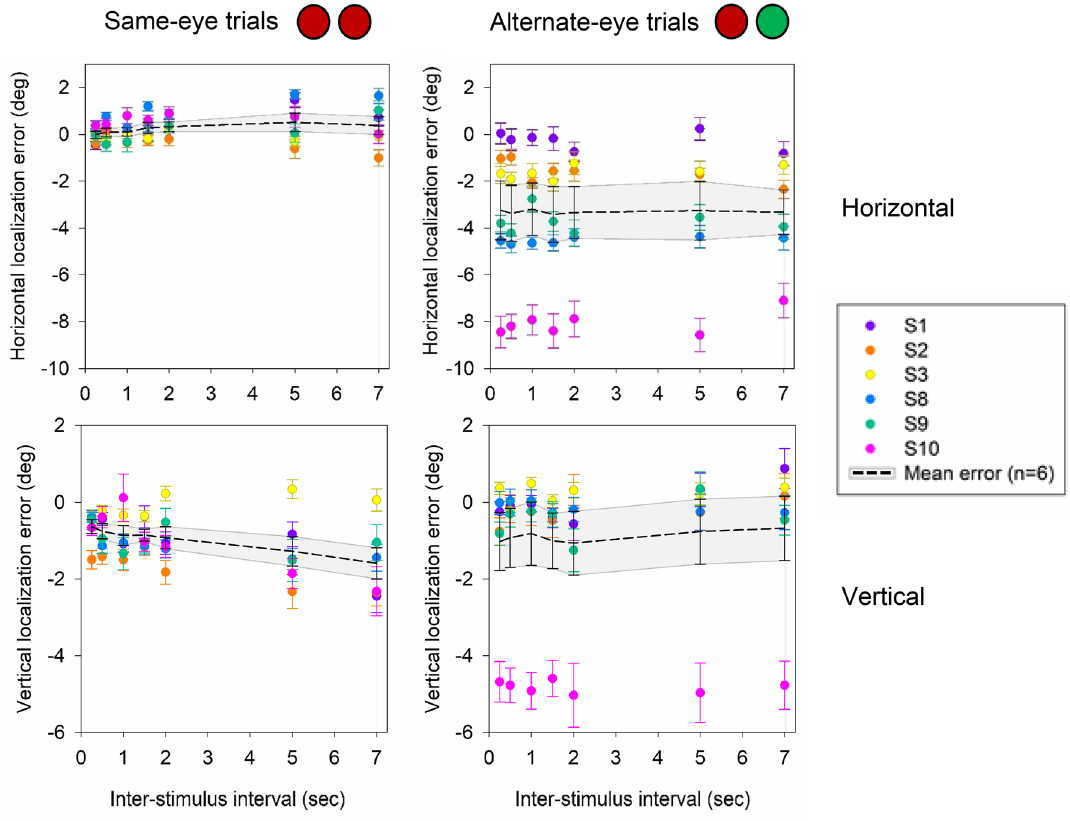
Figure 6. Scatter plot displaying the mean horizontal and vertical localization error across inter-stimulus interval for same eye (LL and RR) and alternate eye (LR and RL) conditions. Black dashed line represents the mean localization error and grey shading represents the standard error of localization for all subjects (n = 6). Each color represents the mean and standard error of horizontal and vertical error in localization for a single subject.